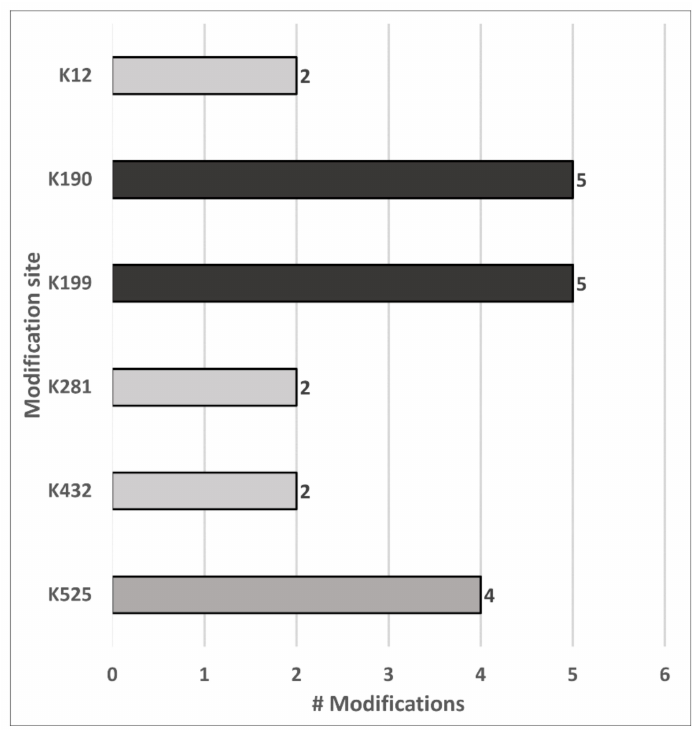
Figure 6. Lysine residues in HSA identified with different ARP-labelled modification